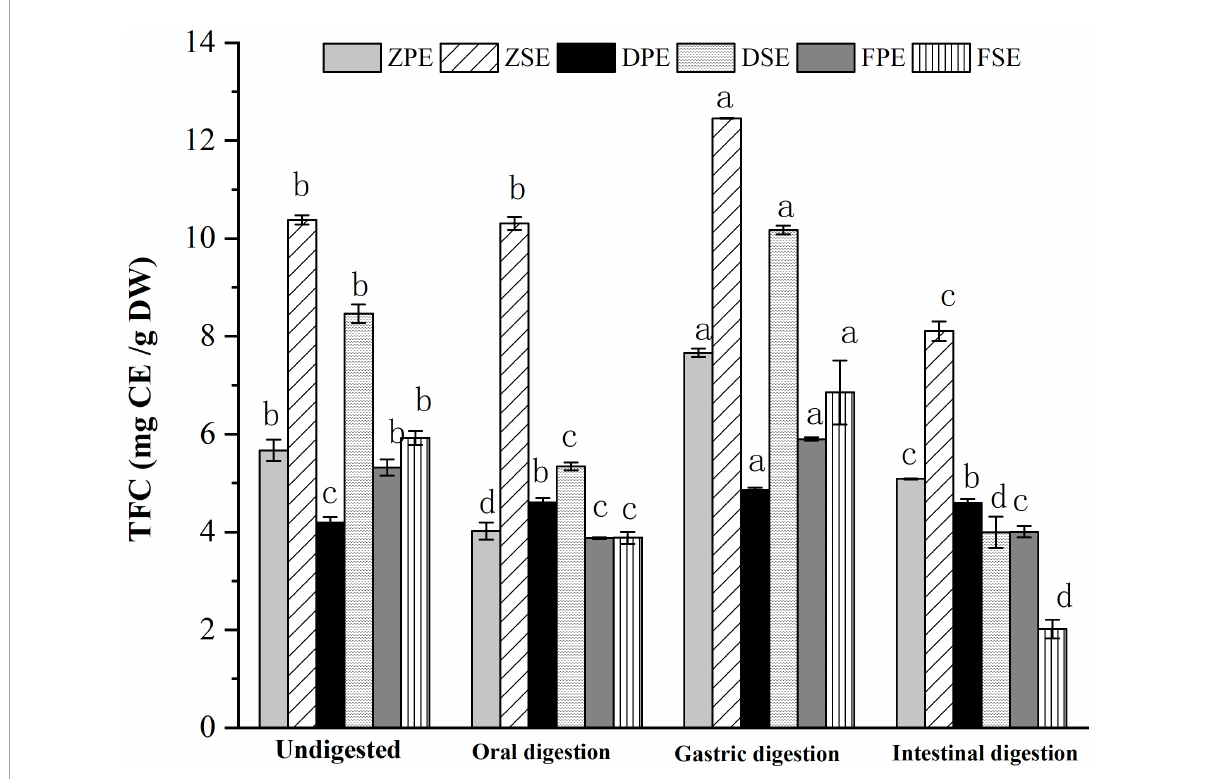
FIGURE2 The changes of TFC in the peel and sarcocarp of Kadsura coccinea fruits during simulated in vitro digestion. Values are presented as means ± SD ( n = 3), ( p < 0.05). ZPE, Zihei peel extract; DPE, Dahong peel extract; FPE, Fenhong peel extract; ZSE, Zihei sarcocarp extract, DSE, Dahong sarcocarp extract; FSE, Fenhong sarcocarp